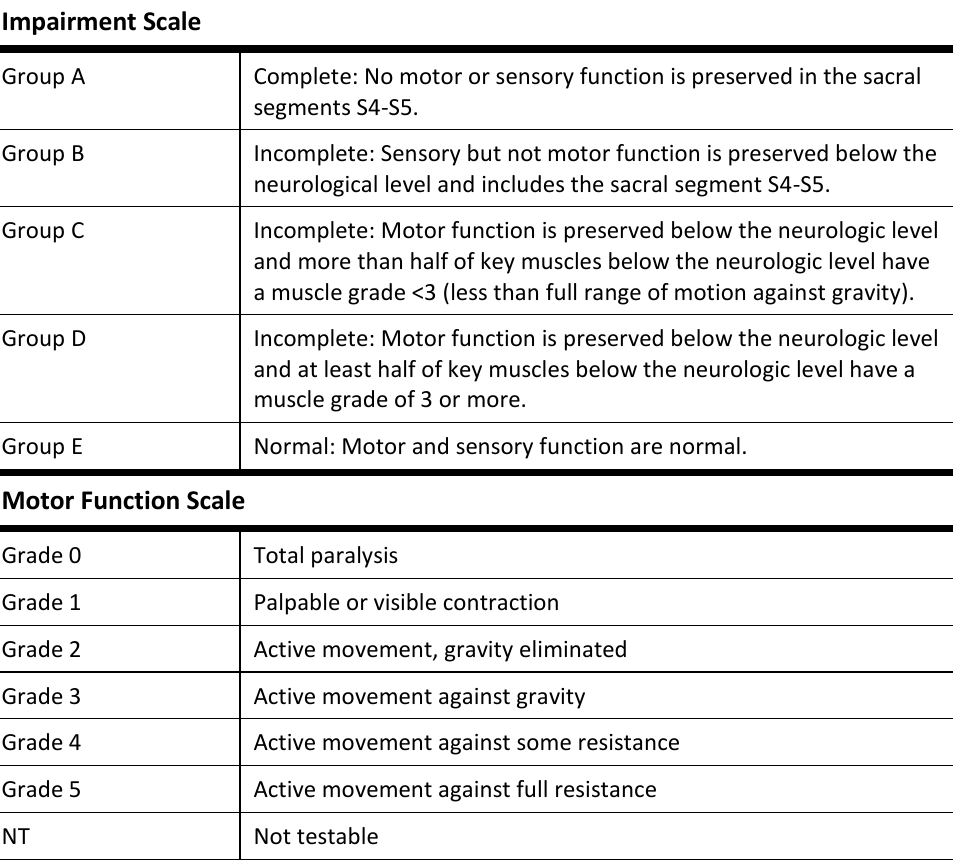
Table F10-2. American Spinal Injury Association Impairment and Motor Function Scales Impairment